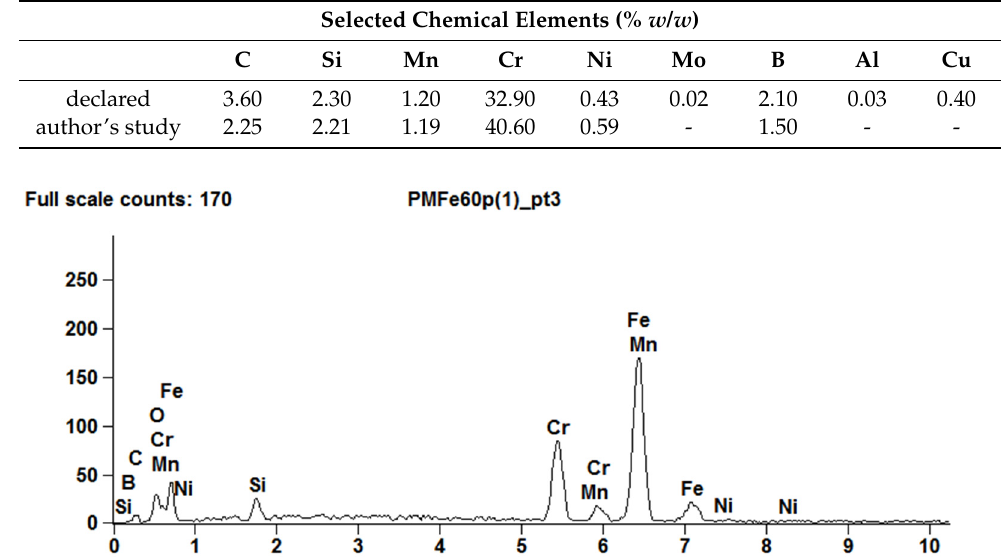
Table 8. The chemical composition of PMFe60P padding weld.